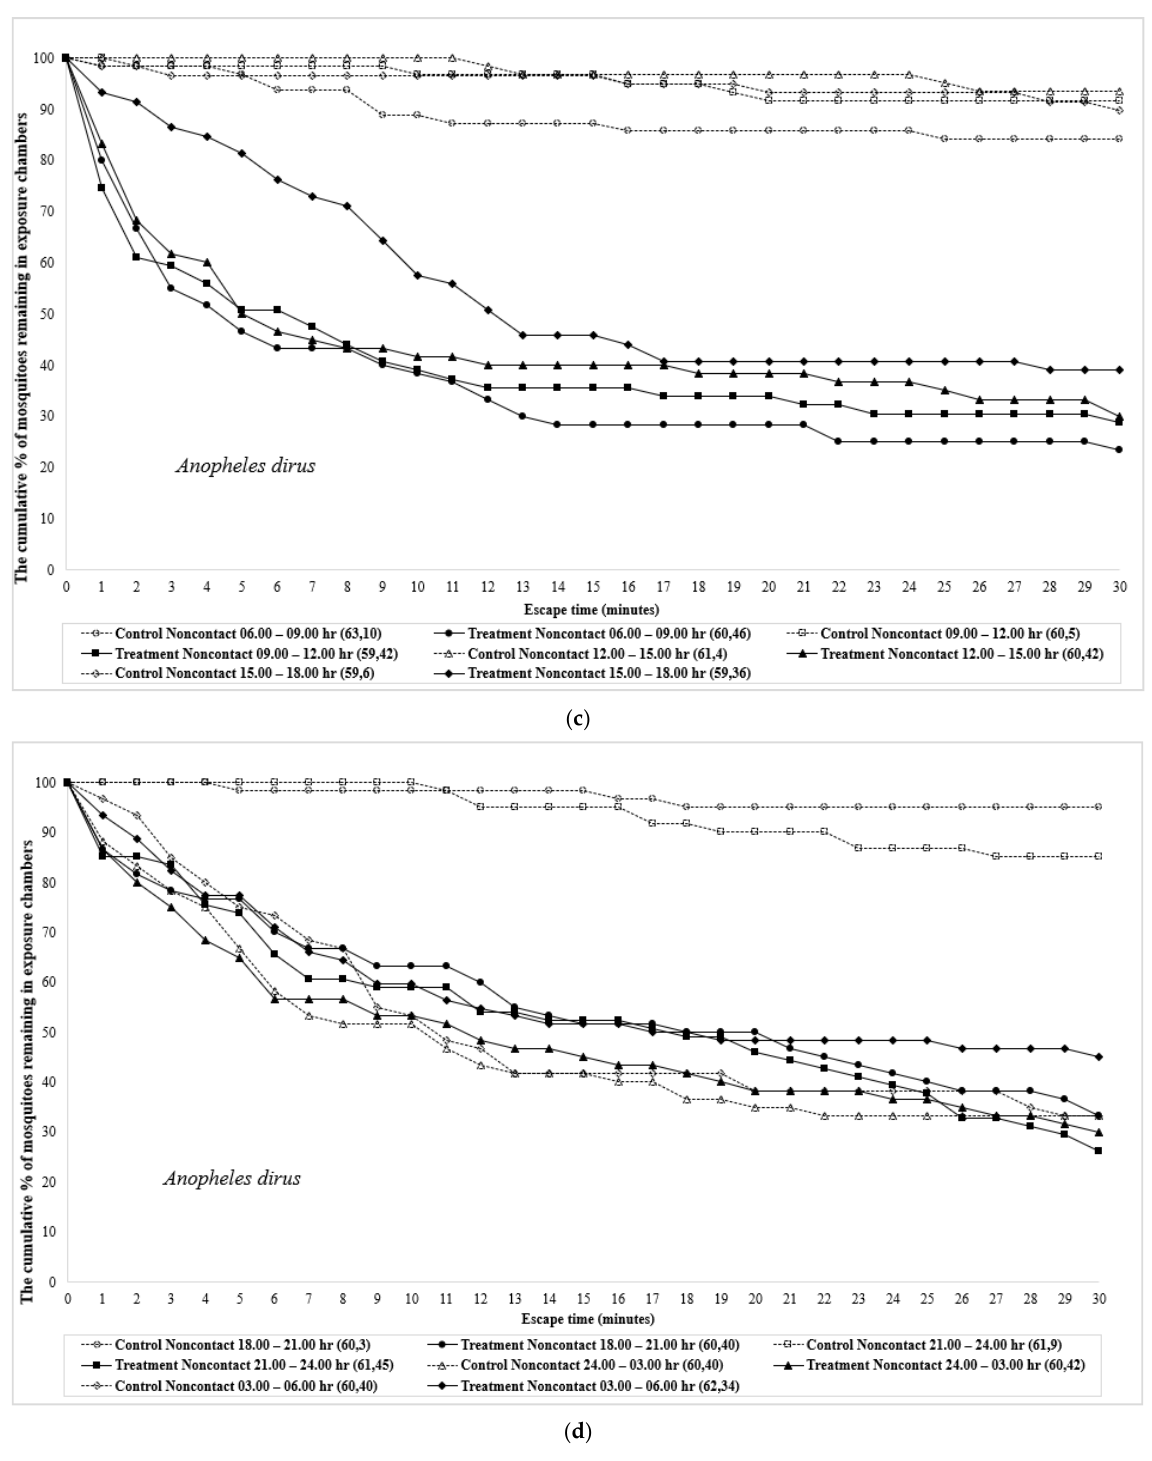
Figure 1. Kaplan–Meier survival curves showing escape responses by ( a ) Anopheles minimus -day; ( b ) Anopheles minimus - night; ( c ) Anopheles dirus -day; and ( d ) Anopheles dirus -night between different time intervals in noncontact trials when exposed to DEET. The number of individuals subjected to test (first number) and those escaped (second number) are given in parentheses.